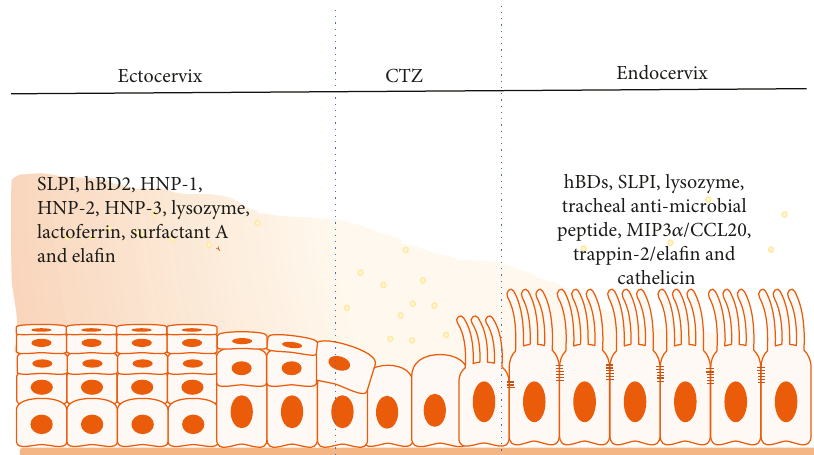
Figure 5: Antimicrobial peptide (AMP) pro fi le and distribution in the ecto- and endocervix. Full names of abbreviations: human β -defensins (hBDs), secretory leukocyte protease inhibitor (SLPI), lysozyme, macrophage in fl ammatory protein-3 (MIP3 α /CCL20), surfactant A, and ela fi n (also known as peptidase inhibitor